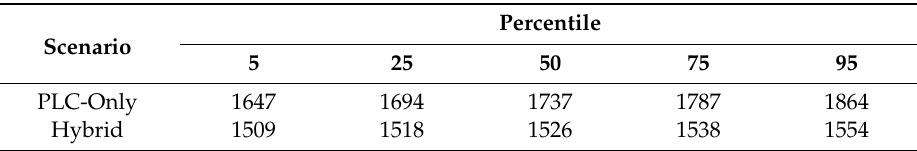
Table 12. Sensitivity Analysis Result per Deployment